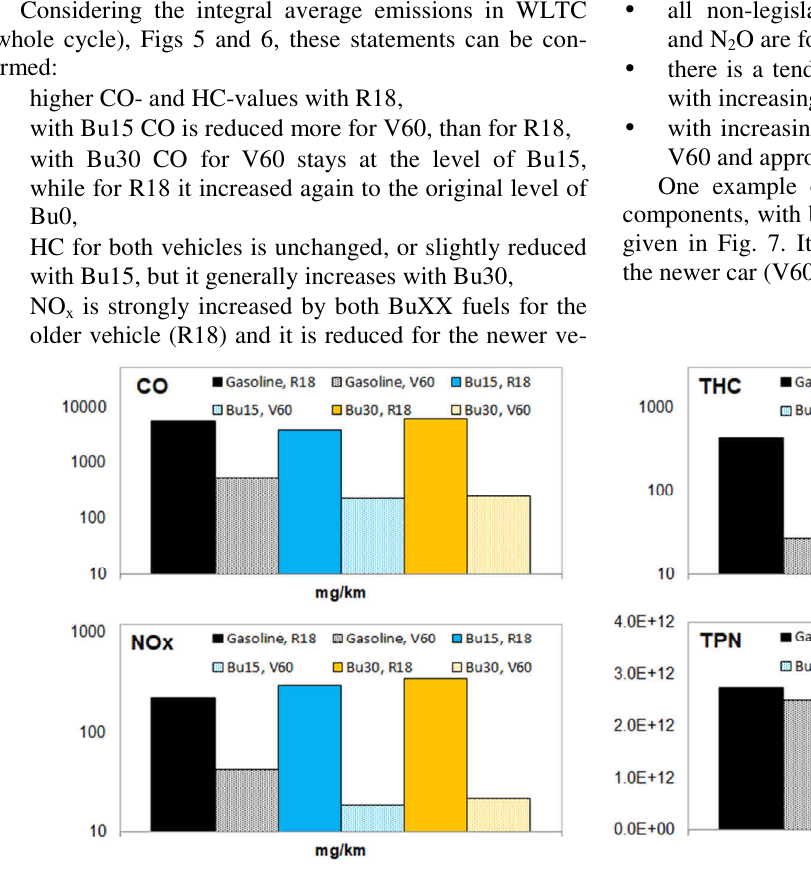
Fig. 5. Comparisons of emissions R18 vs V60 in WLTC cold with Bu0, Bu15 & Bu30